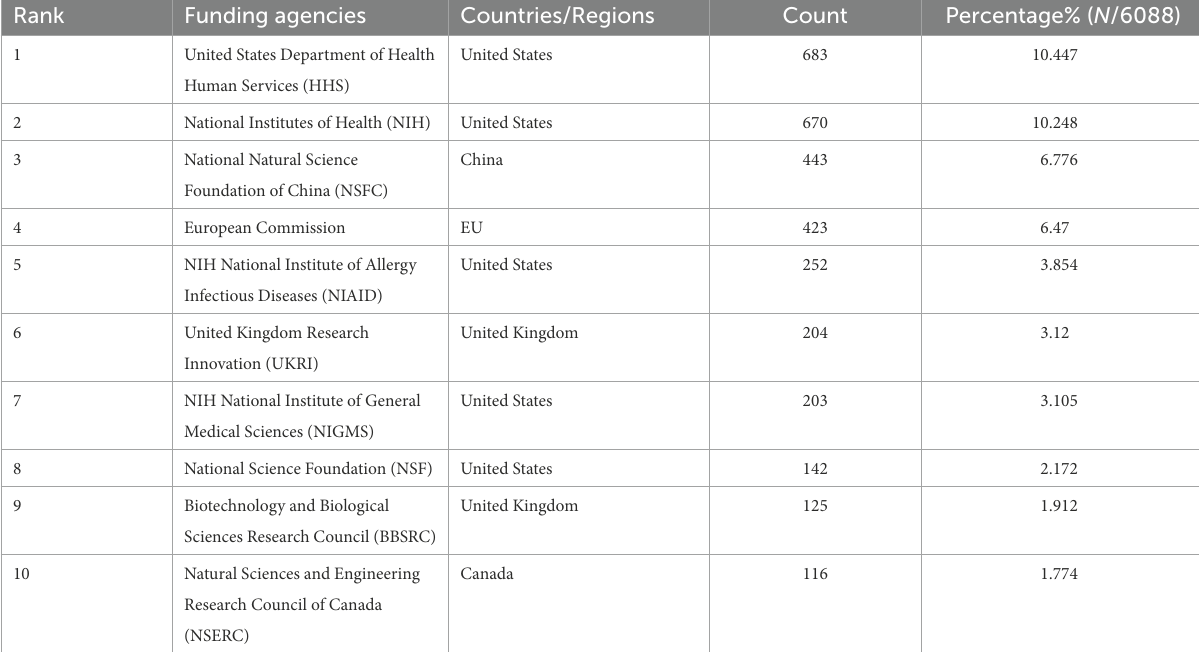
TABLE 3 Top 10 related funding agencies.